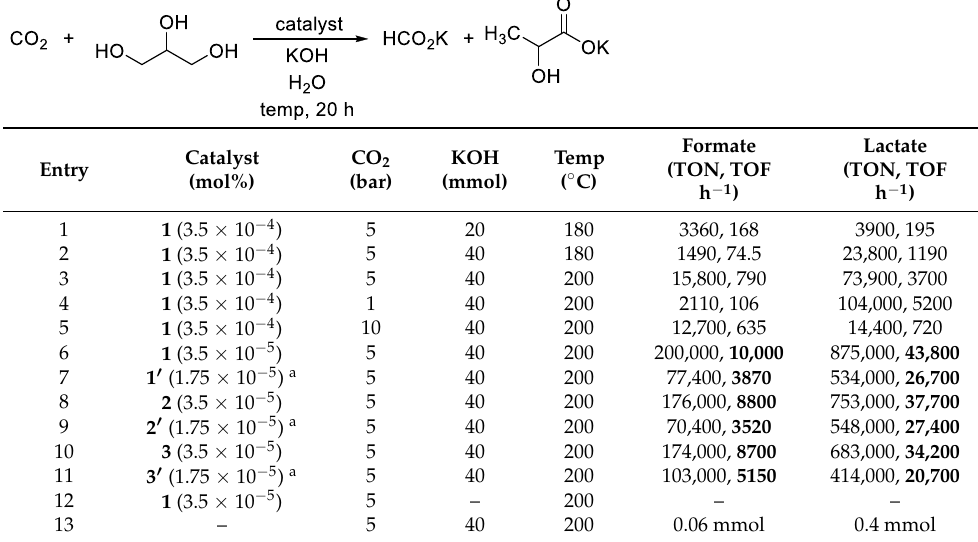
Table 1. Transfer hydrogenation of CO 2 in glycerol.